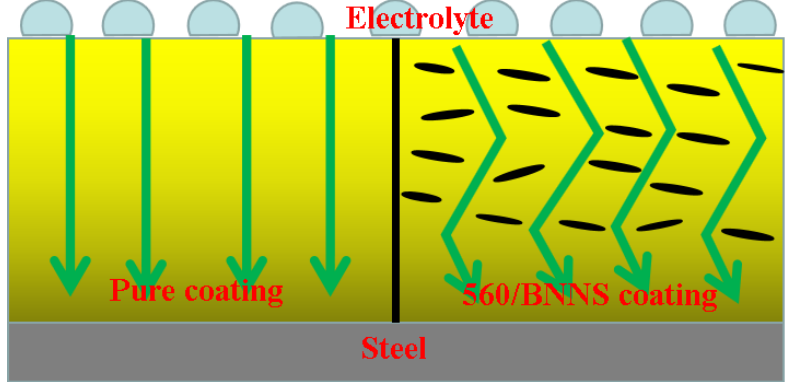
Figure 12. Corrosion resistance mechanism model diagram.